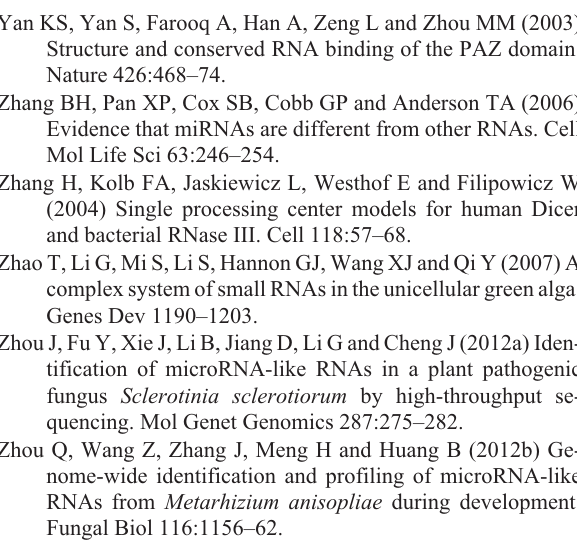
Figure S1 - Flowchart of study design. Figure S2 - Phylogenetic tree of the dicer and argonaute proteins. Figure S3 - Aligment analysis of miRNAs-like in the ge- nome of P. brasilensis . Table S1 - Access numbers of the proteins used to construct the phylogenetic trees Table S2 - Oligonucleotide sequences used in the present study. Table S3 - miRNAs-like homologs to other fungi species identified in the genome of P. brasiliensis Pb